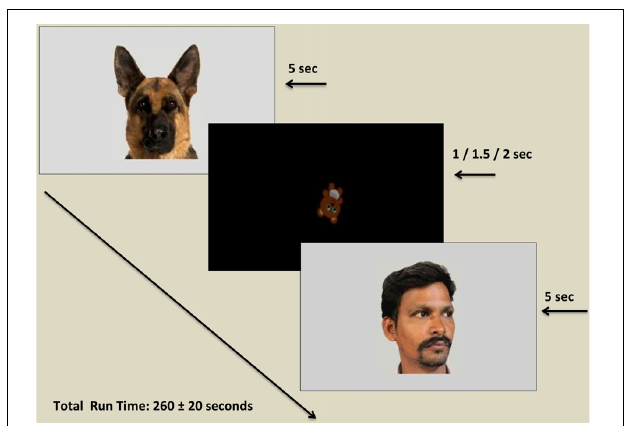
FIGURE 1 | Diagram illustrating stimulus presentation within the eye tracking paradigm. Each target stimulus was displayed for a period of 5 s (5000 ms) followed by an inter-stimulus image displayed for a variable period of 1, 1.5, or 2 s. Permissions and image licenses have been obtained from the copyright holders (Source: ©Eric